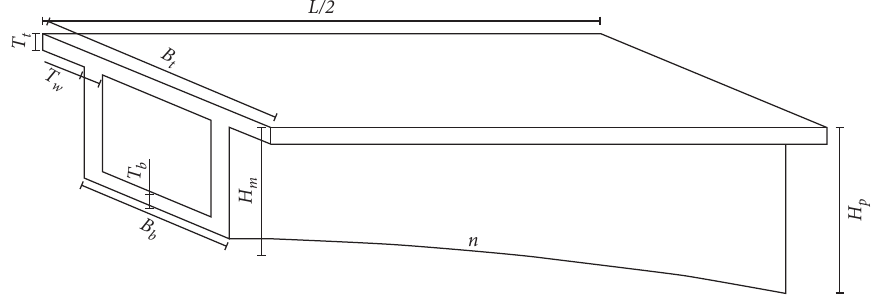
Figure 1: Simplified box girder and design parameters. Table 1: Parameters and their value from the bridge parameters dataset.